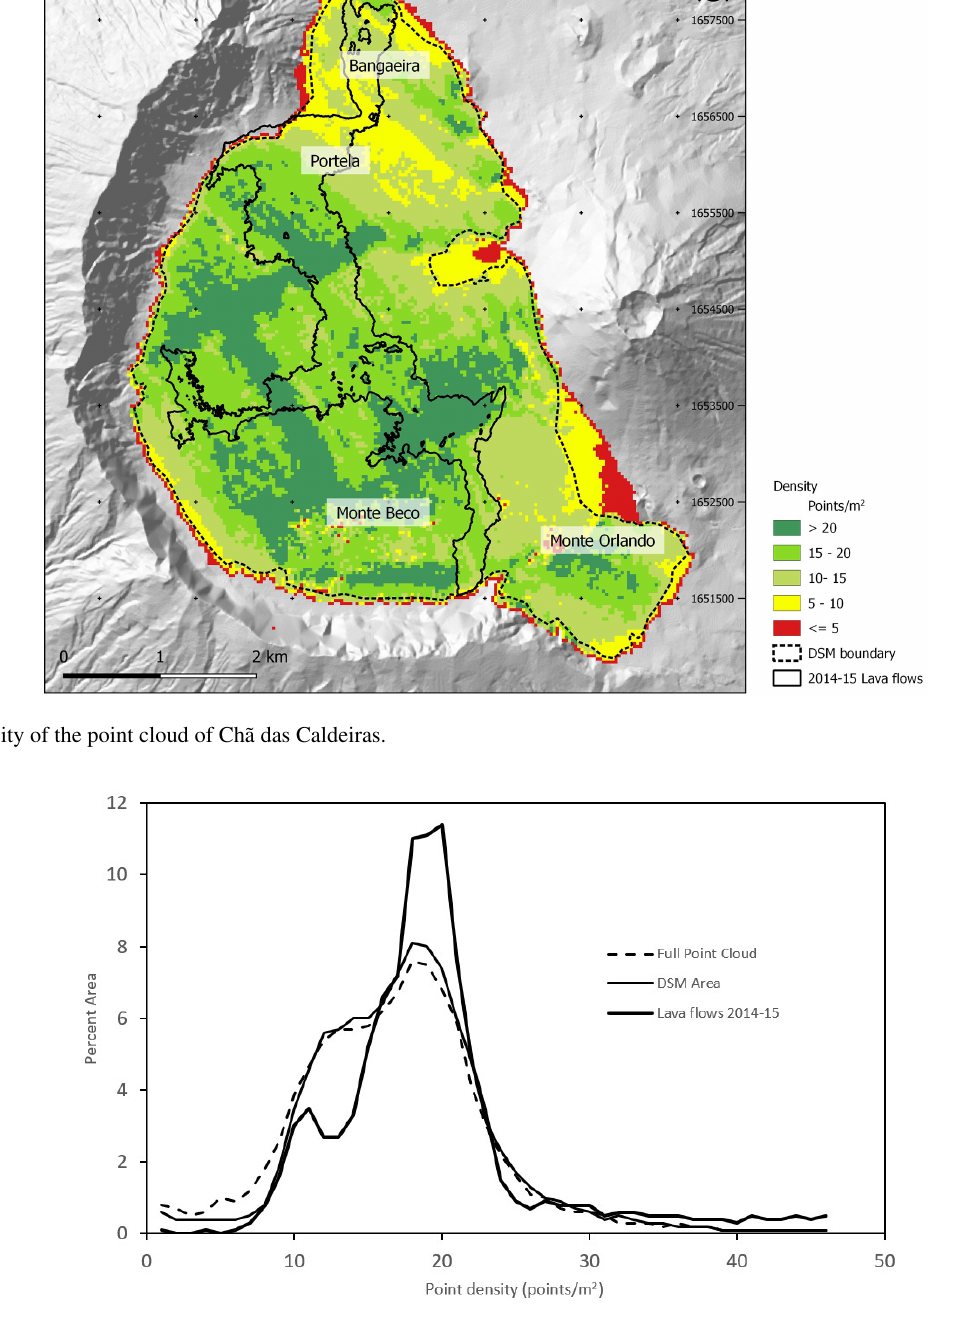
Portela–Bangaeira area, with most of the lava flows showing much higher densities (Fig. 9), as revealed by the bimodal histogram of Fig.